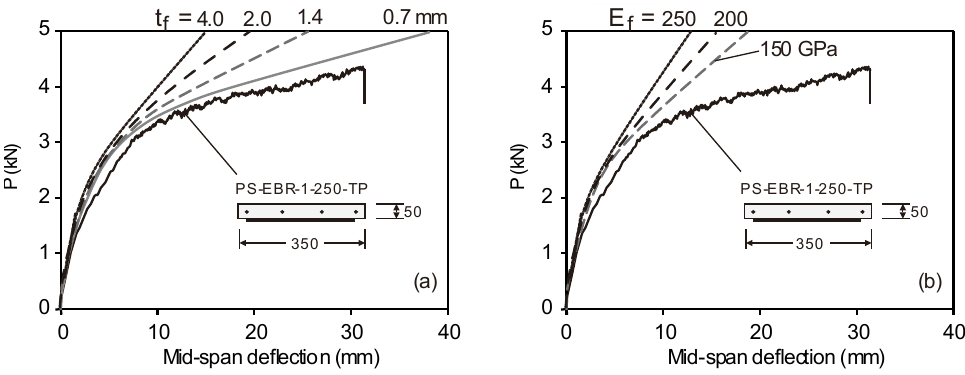
Figure 9. Effects of ( a ) thickness of CFRP, and ( b ) and modulus of elasticity of CFRP. Table 3. Normal stress of CFRP sheets at concrete and tensile failure load for different CFRP